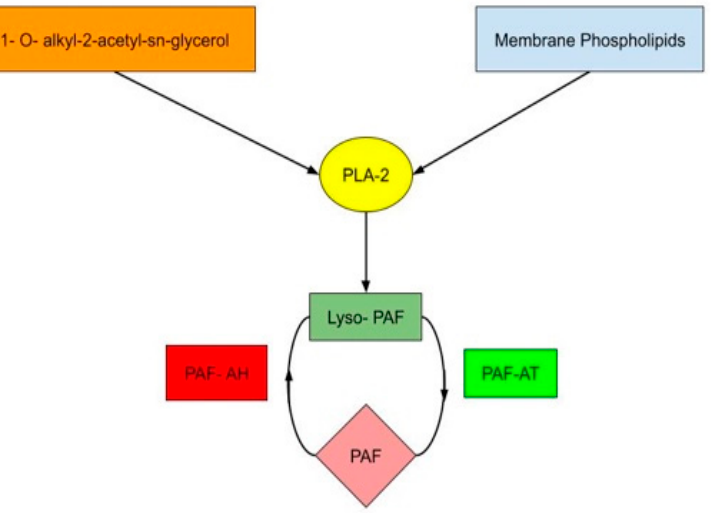
Figure 1. PAF production via the remodeling and de novo pathway. Phospholipase A2 (PLA-2) is a central point of PAF production via the modification of existing membrane phospholipids and the addition of phosphocholine to 1-0-alkyl-2-acetyl-sn-glycerol. Platelet-activating factor acyltransferase (PAF-AT) takes this further to form functional PAF, whereas platelet-activating factor acytelhydrolase (PAF-AH) breaks down PAF into its inactive form.